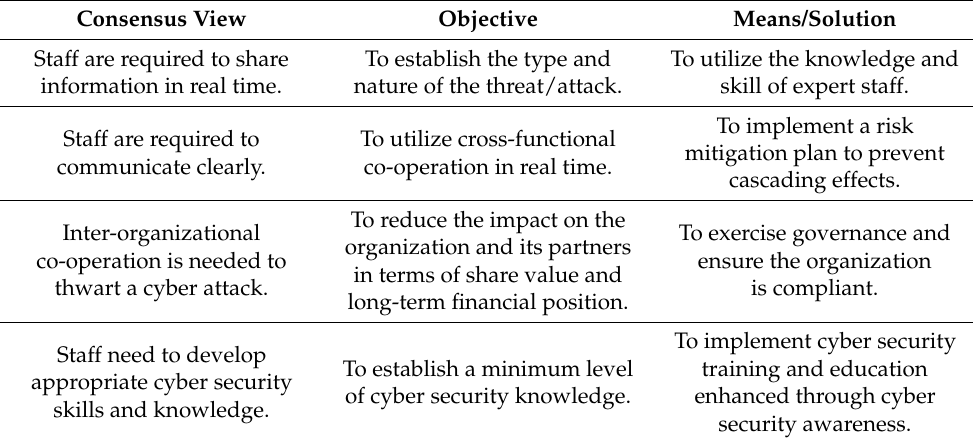
Table 1. Results of the mind mapping